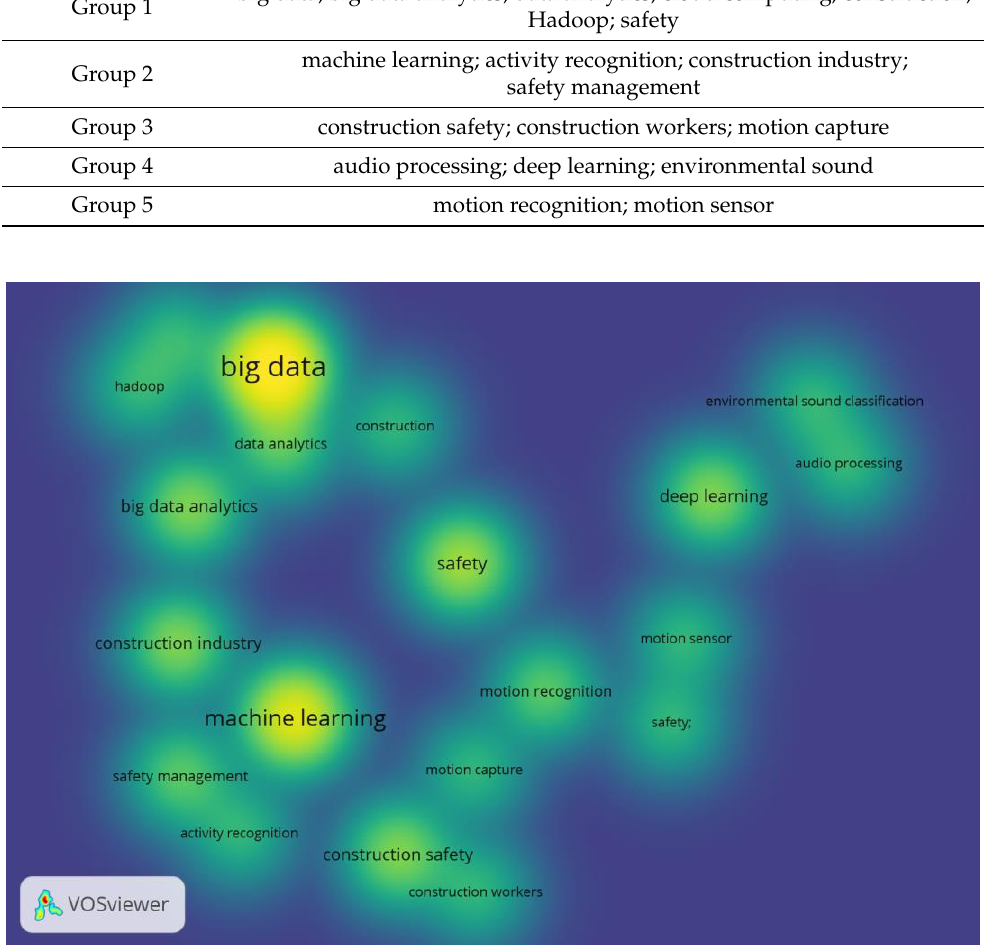
Figure 3. Keyword hotspot maps.